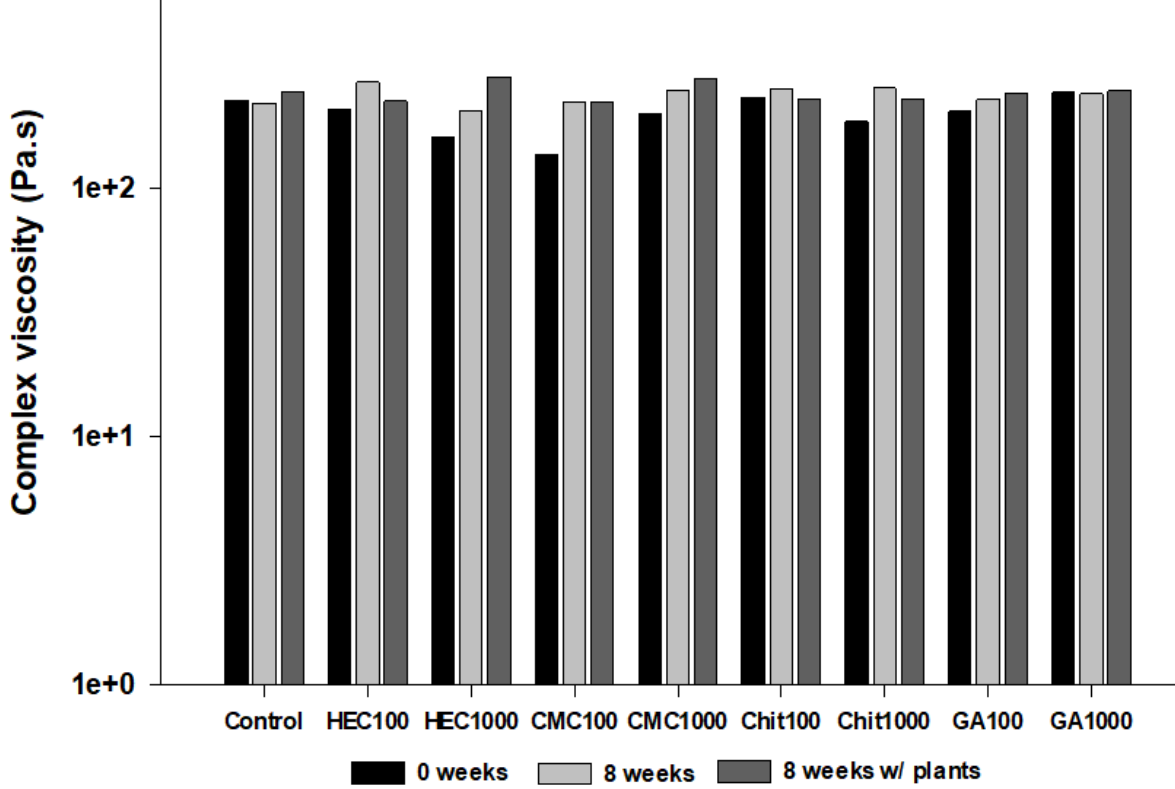
Figure 4. η * (Pa · s) extracted from the frequency sweep experiments at a constant frequency of 1 Hz for media supplemented with HEC, CMC, chitosan, or gum arabic at two concentrations, at the beginning (0 weeks) and at the end (8 weeks–without plants; 8 weeks w/plants–with plants) of the eight-week culture period. CMC: carboxymethylcellulose sodium salt; Chit: chitosan; GA: gum arabic; HEC: hydroxyethyl cellulose; η *: viscosity; 100: 100 mg L − 1 ; 1000: 1000 mg L − 1 .